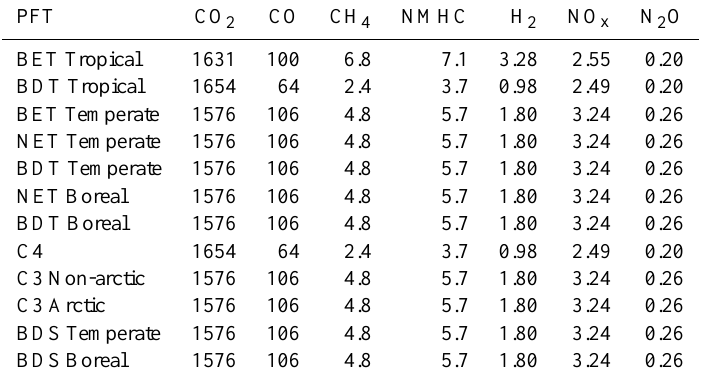
Table 3. PFT-specific emission factors (gspecie(kgdm) − 1 ) for trace gases. CO 2 : carbon dioxide, CO: carbon monoxide, CH 4 : methane, NMHC: non-methane hydrocarbon, H 2 : hydrogen gas, NO x : nitrogen oxides, N 2 O: nitrous oxide.